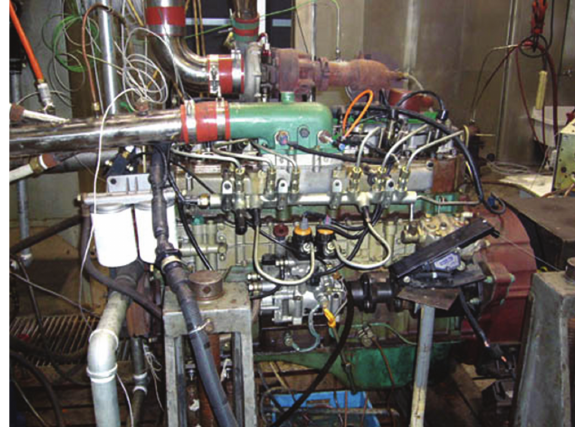
Figure 5: Reconstructed test engine.